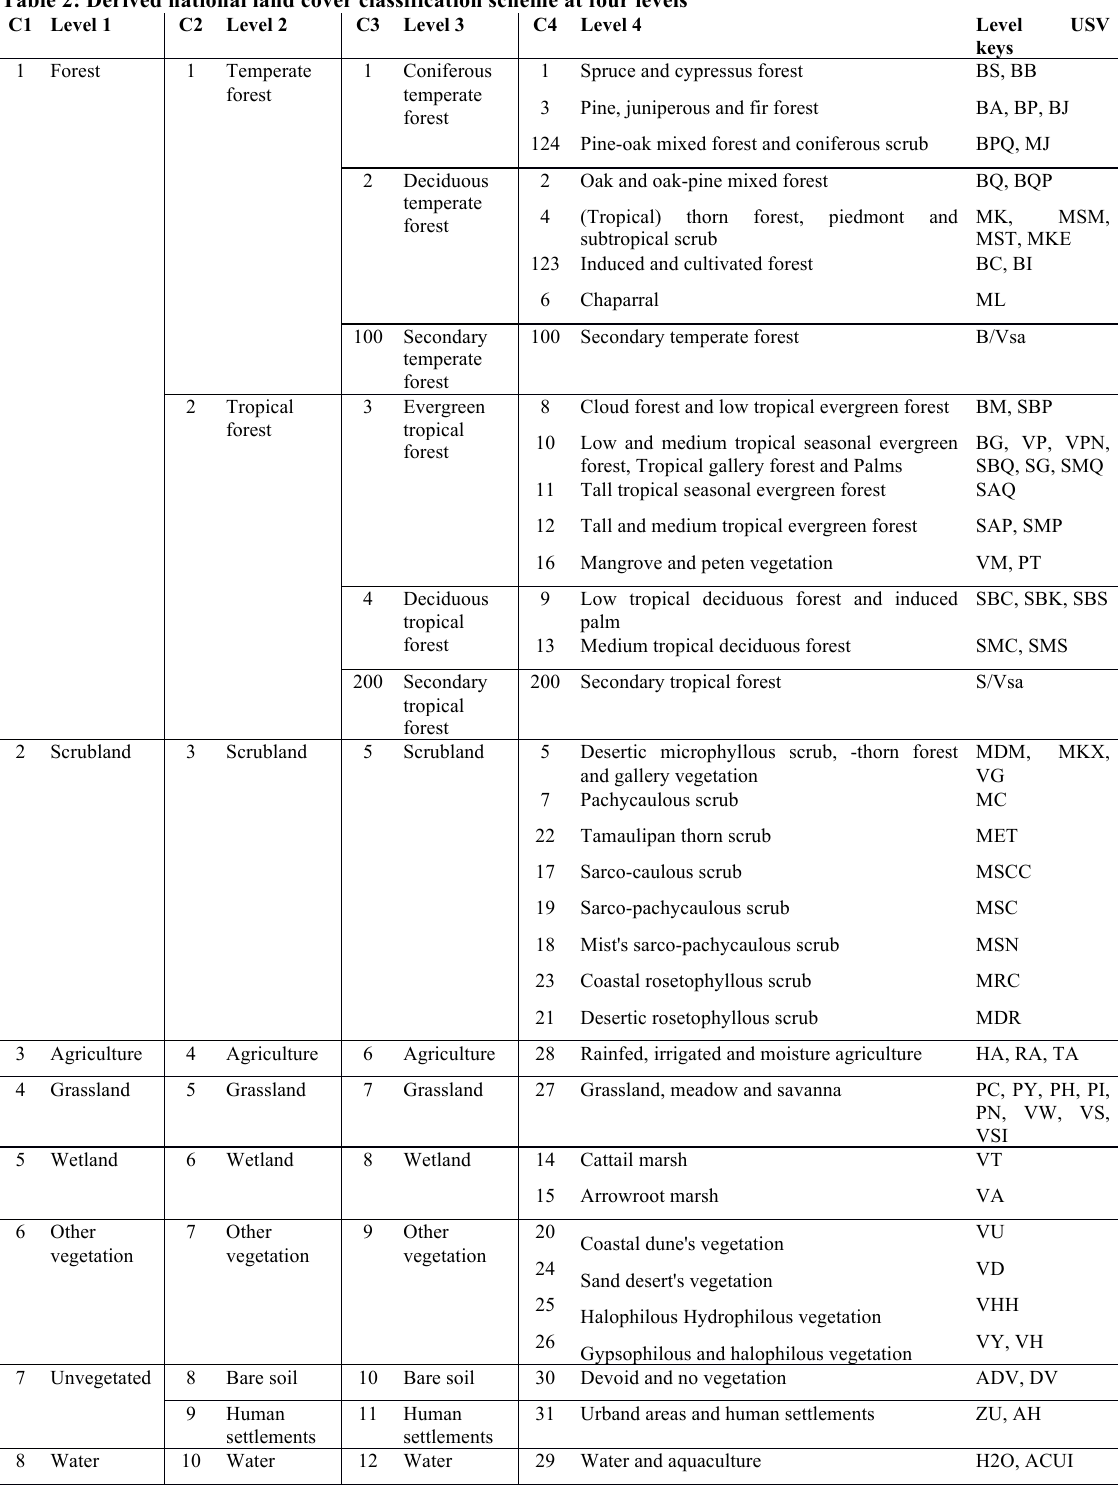
Table 2: Derived national land cover classification scheme at four levels C1 Level